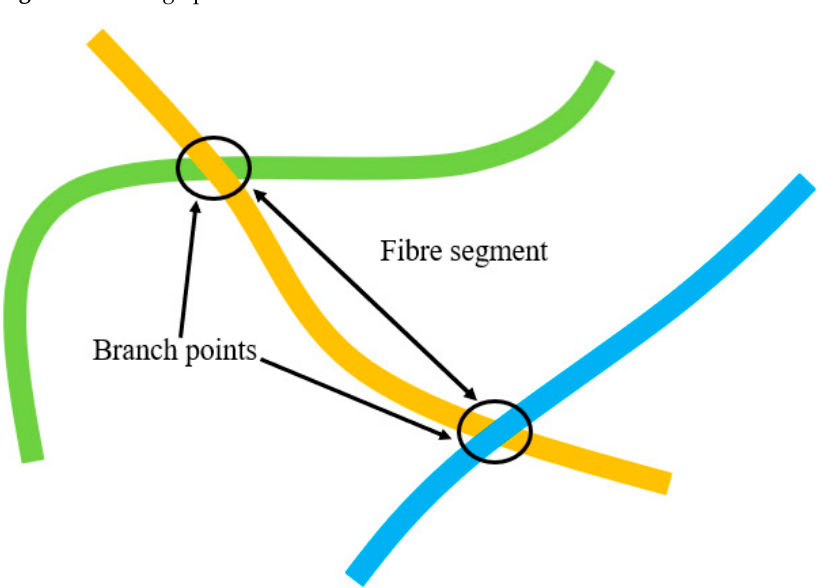
Figure 4. Branch points and fibre segments .